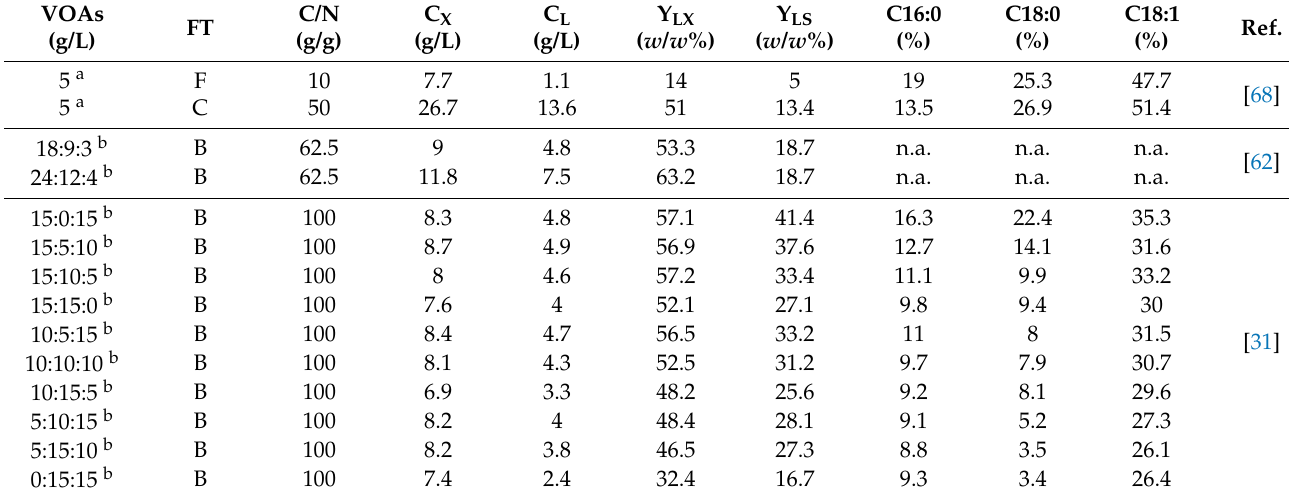
Table 2. Bioconversion of volatile organic acids (VOAs) to single-cell oil by the biocatalyst C. oleaginosus working at 30 ◦ C and pH